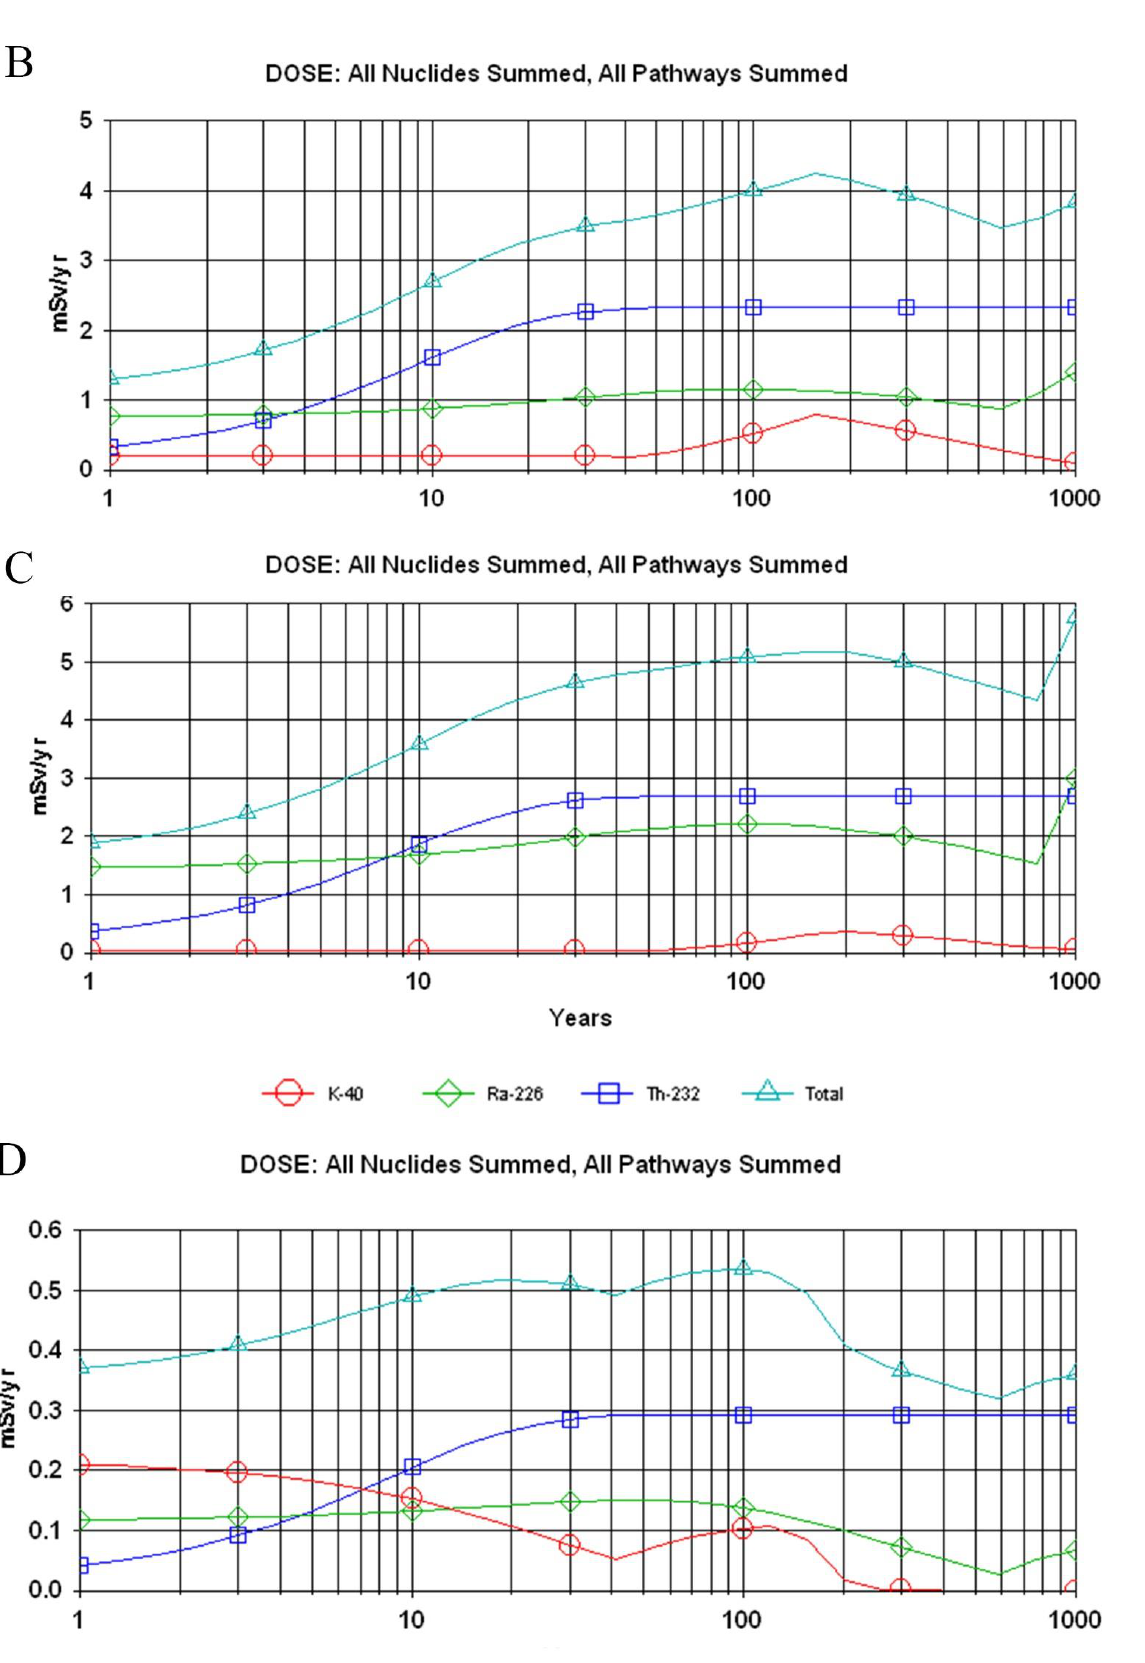
Figure 2. Total annual dose from all radionuclides and all pathways. ( A ) Ajka coal, ( B ) Ajka red mud, ( C ) Almásfüzitő red mud, ( D ) Zalatárnok drilling mud, ( E ) Ú rkút manganese.